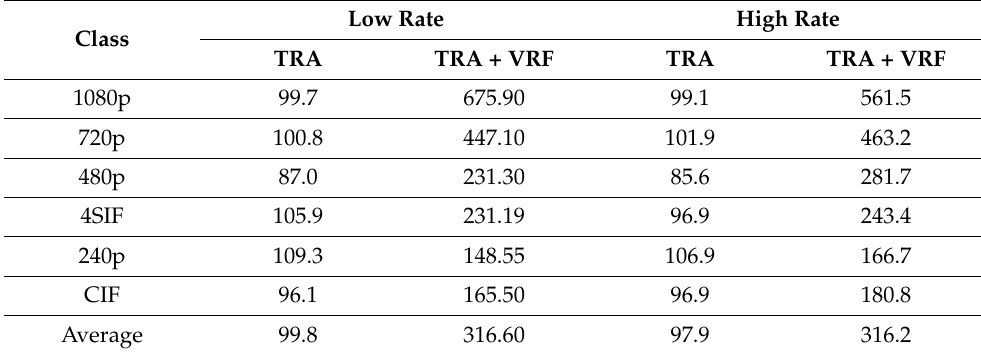
Table 7. Encoding time (%) compared to